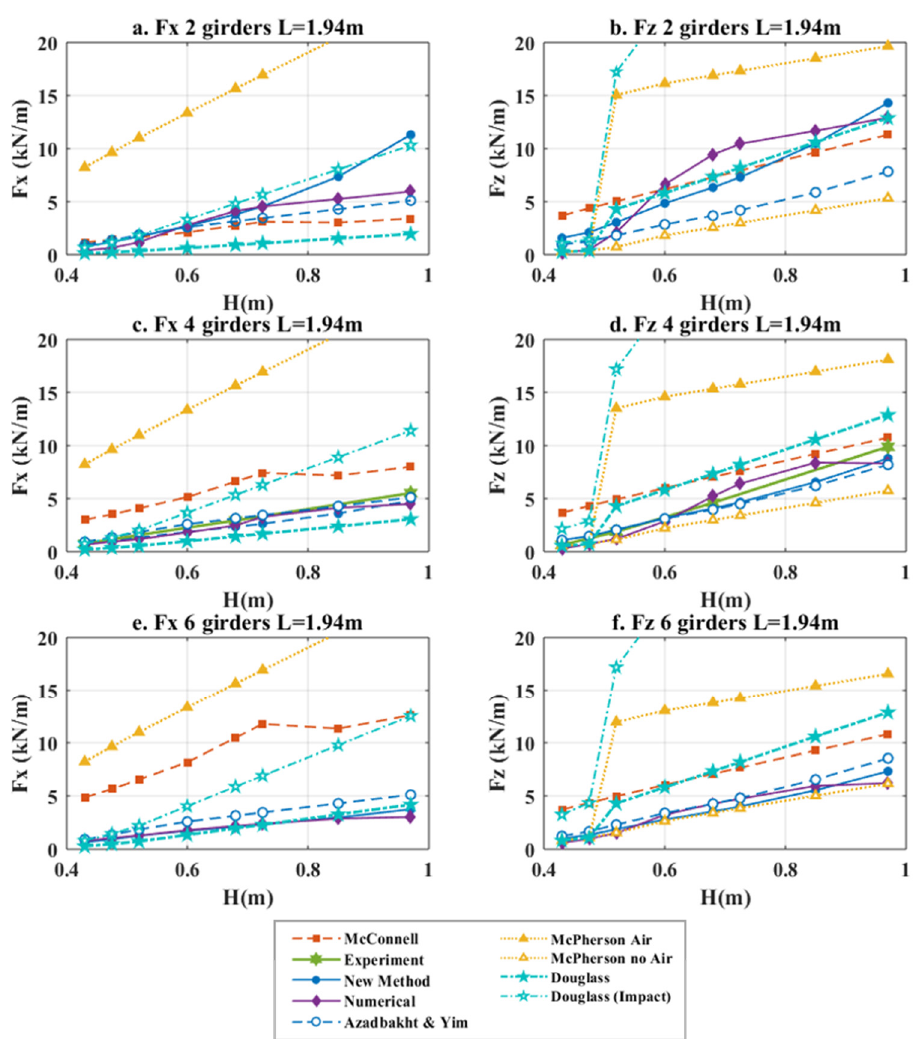
Figure 23. Comparisons of the maximum wave forces predicted by different methods with the numerical results and experimental measurements, for three decks with different number of girders ( Ng = 2, 4 and 6).